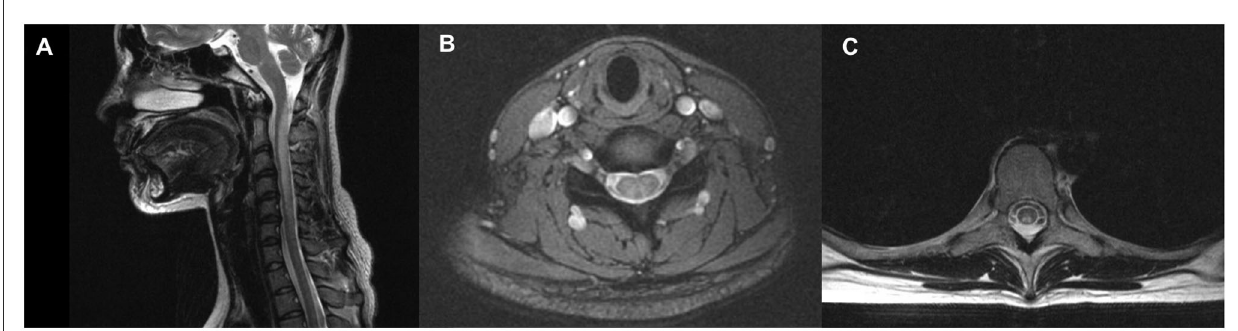
FIGURE1 Spinal cord Magnetic Resonance Imaging (MRI) of a patient with N 2 O -abuse who complained of progressive unsteadiness while walking and limb numbness for 14 days. (A) Sagittal T2 MRI of the cervical spine showed a longitudinal hyperintensity signal C1–C6. (B) Axial gadolinium-enhanced T2 MRI showed symmetric and inverted V-shaped hyperintense signals in the dorsal columns of the cervical spinal cord. (C) Axial gadolinium-enhanced T2 MRI showed symmetric and inverted V-shaped hyperintense signals in the dorsal columns of the thoracic spinal